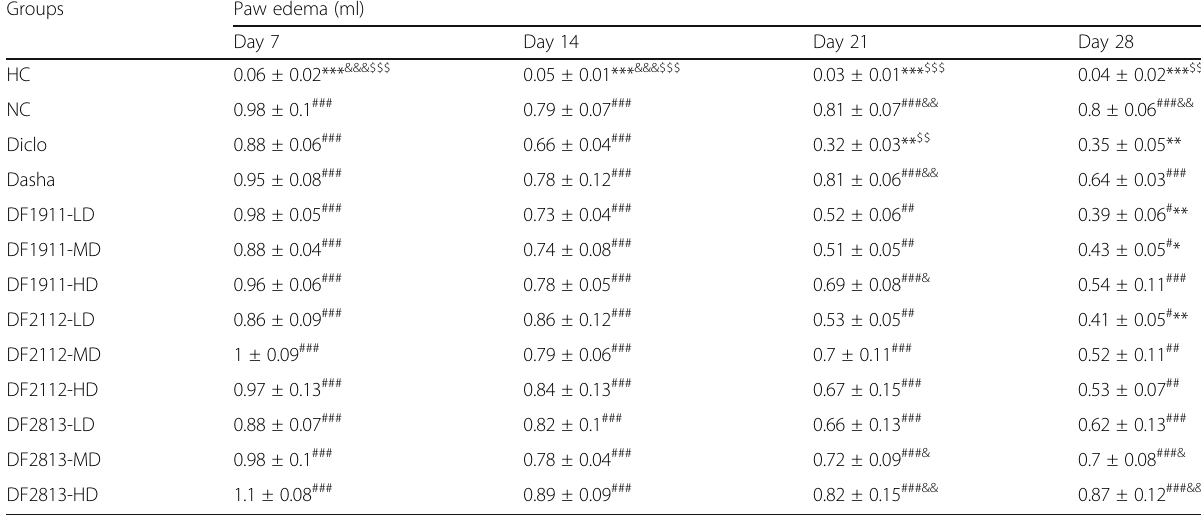
Table 5 Effect of test formulations on CFA induced rat paw edema